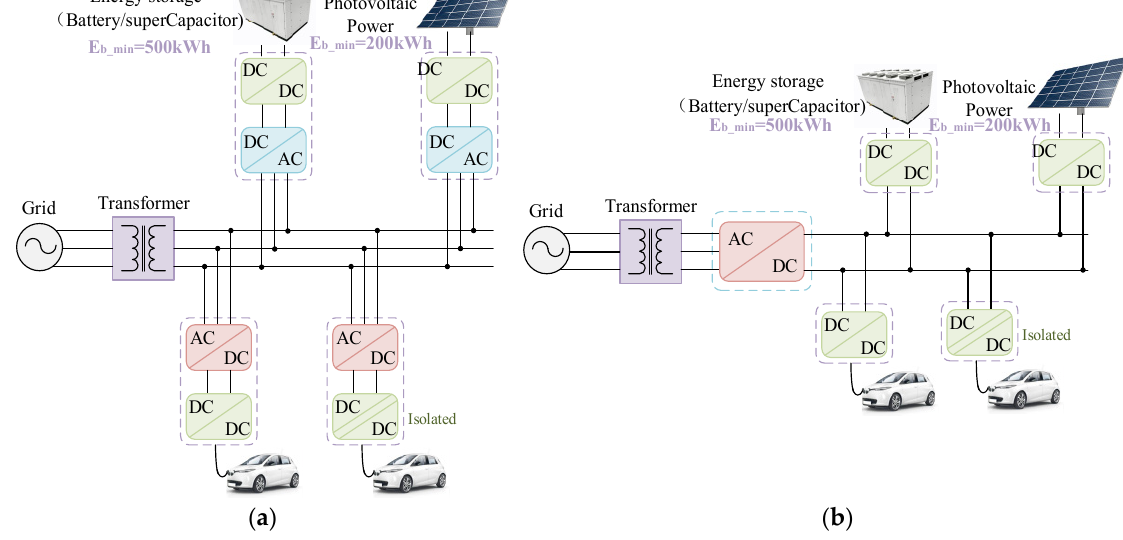
Figure 3. Electric vehicle fast-charging system architecture. ( a ) AC coupling con fi guration method. ( b ) DC coupling con fi guration method.